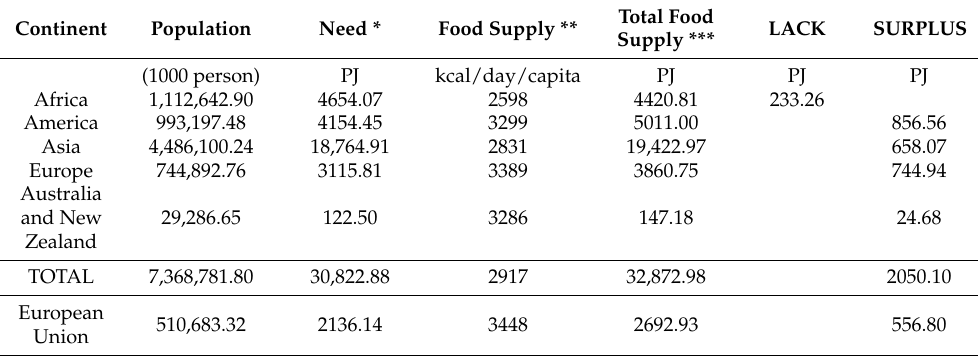
Table 1. Food supply on continents: need (2735 kcal/capita/day) vs. fact, 2017. Data source: FAOSTAT [39], edited by